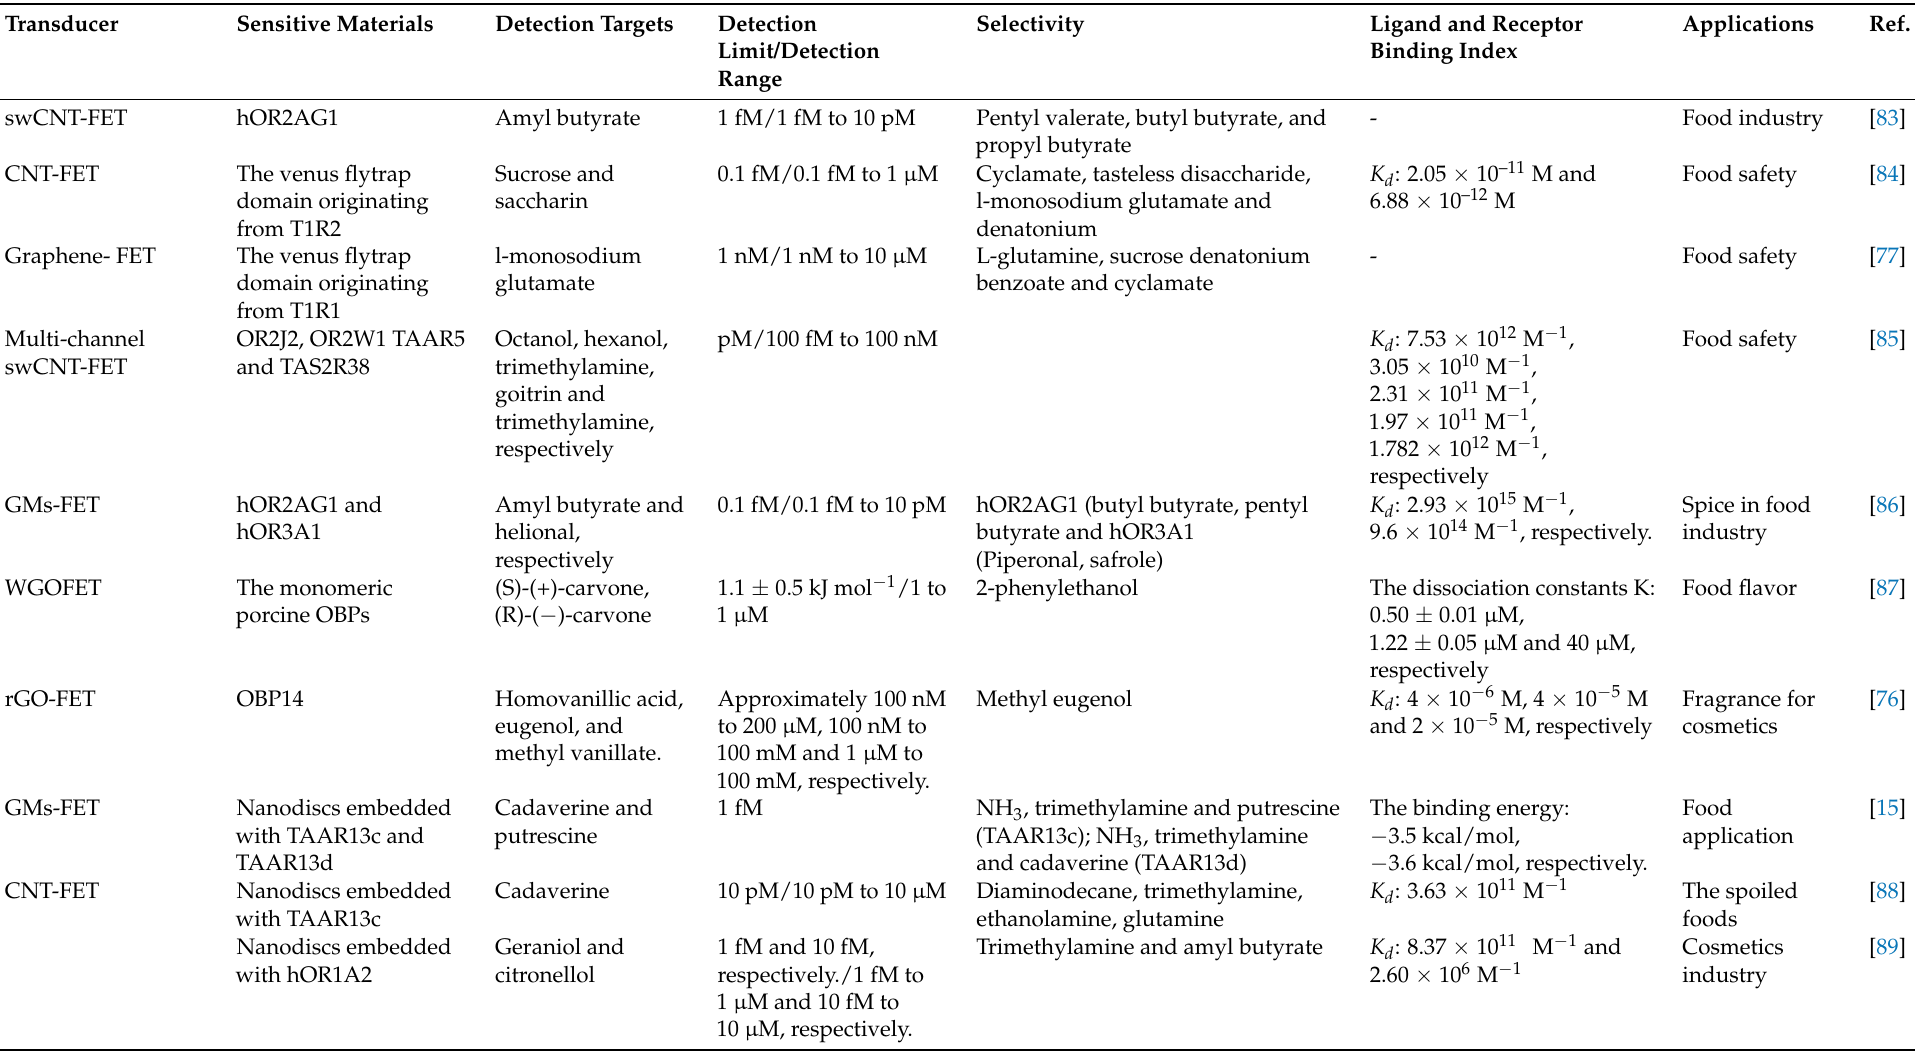
Table 1. Summary researches of detection strategies on biomimetic olfactory and gustatory biosensors based on field effect-based